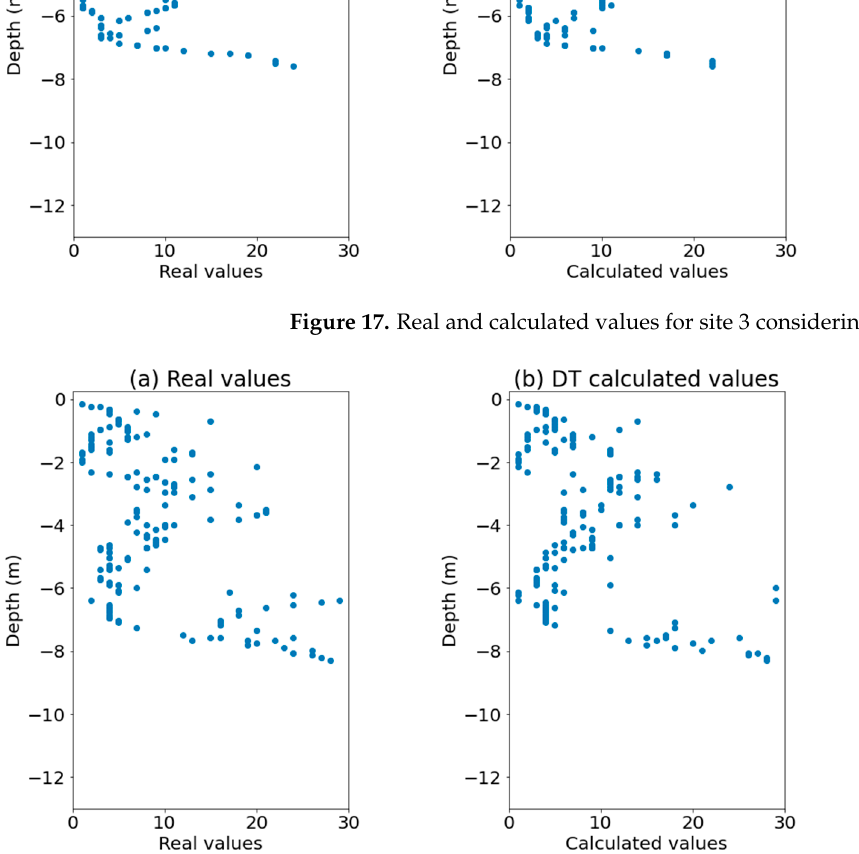
Figure 18. Real and calculated values for site 4 considering depth. ( a ) Real values. ( b ) Values calcu- lated by DT. ( c ) Values calculated using RF.